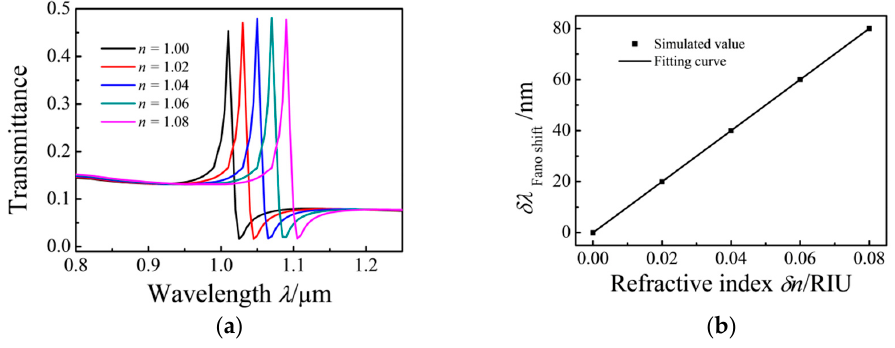
Figure 4. ( a ) Transmission spectra for the MIM waveguide coupled with ring and rectangular cavities with changing n ( h = 100 nm); ( b ) Shift in the Fano resonance peak as a function of refractive index ( δ n ).